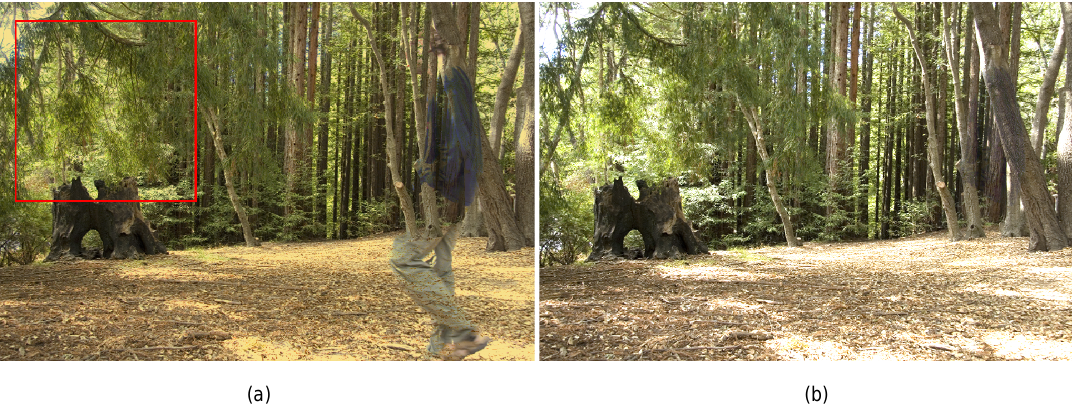
Figure 6. Detailed comparison of the branches and their shadows. Low-rank component obtained by RPCA ( a ) and the proposed approach ( b